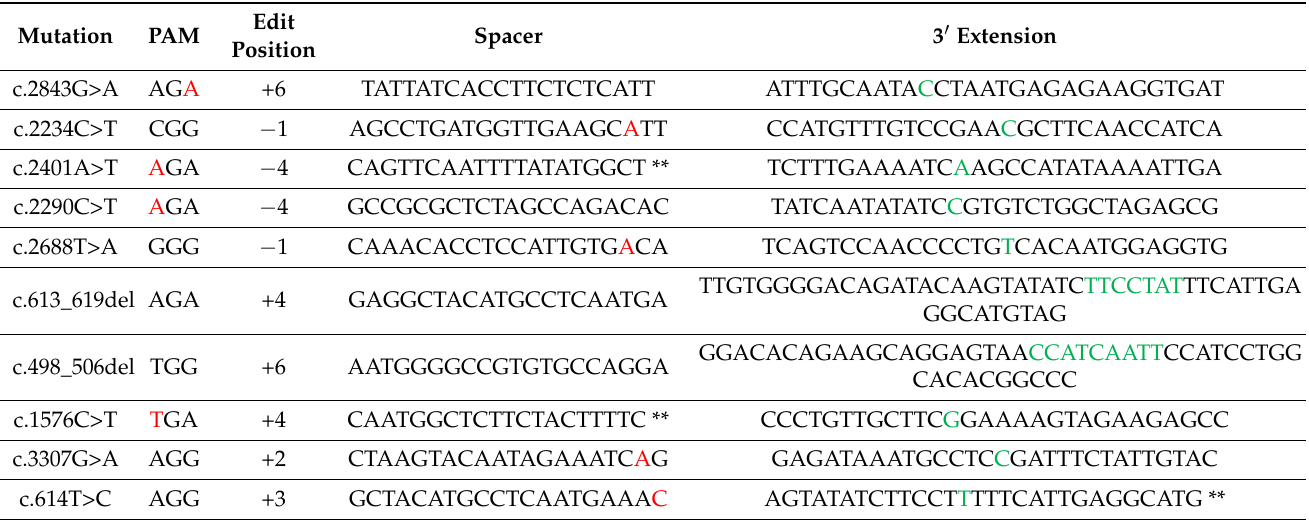
Table 4. Prime editing design for the top 10 most frequent CRB1 variants in the Leiden Open Variation